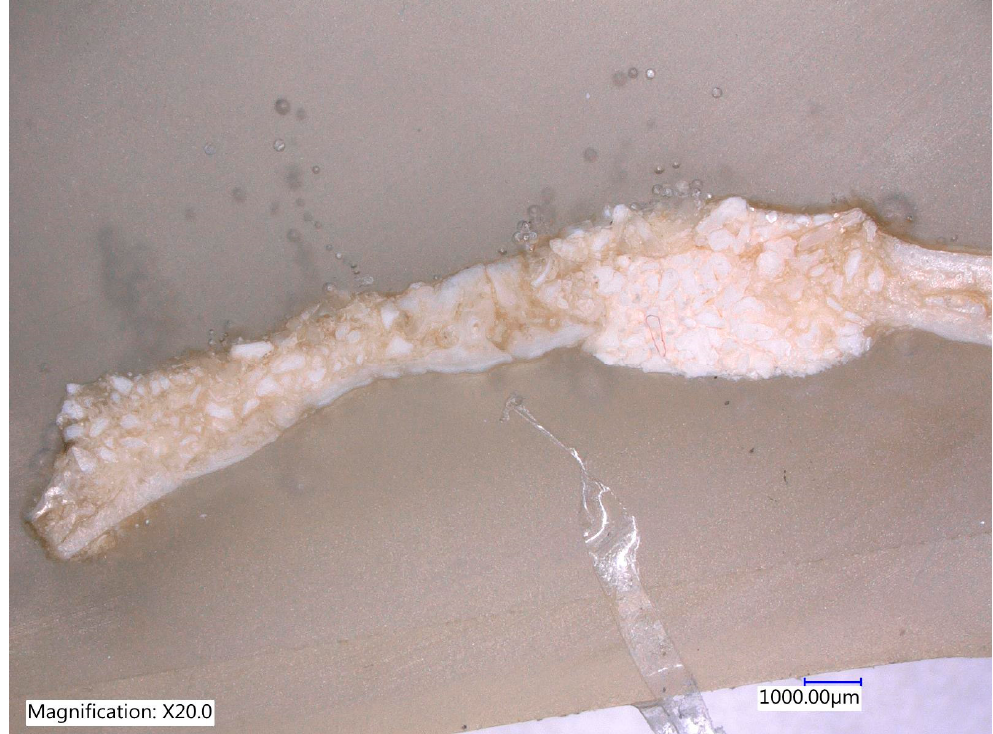
Figure 12. The MinerOs site after an 8-week of follow up with the new bone formation on the right side and on the left side some reduction of biomaterial was observed (Magnification 20×).